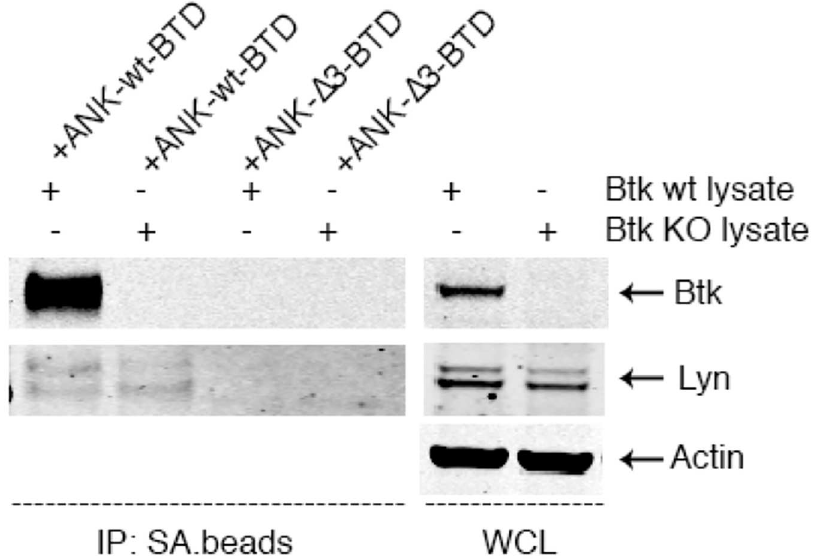
Fig 4. ANKRD54selectively binds to BTK. Cos7 cells transiently-transfected with ANKRD54-wt or ANKRD54- Δ 3 mutants followedby immunoprecipitation with streptavidin magnetic-beads. The IP complexes were incubatedwith wholecell lysates obtainedfrom wt and Btk-KO primary spleencells. The absenceof BTK (secondlane from left to right) did not enhancethe enrichmentto LYN. β -Actin used as quantity-indexof protein, indicating equal-loading control of